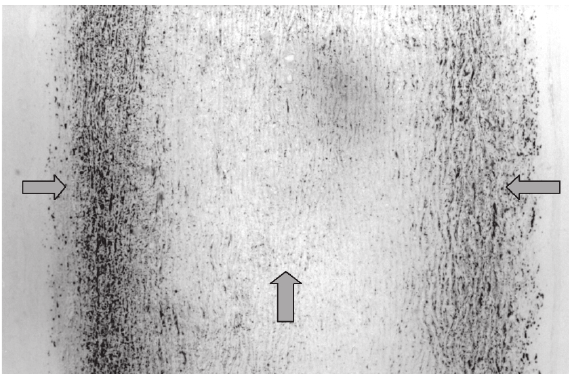
Fig. 4 - Fotomicrografia mostrando corte transversal da cúspide aórtica tratada com etanol 80%, sem sinais de calcificação após 15 dias de implante. E80% subgrupo 15 dias (von Kossa 40x).